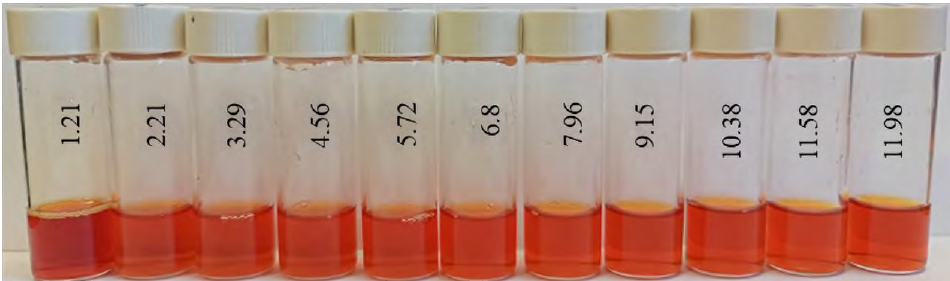
Figure 9. Photo of samples of Se NPs negative sol in various pH media.